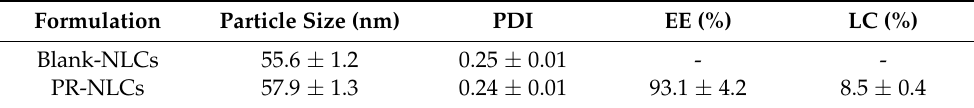
Table 1. The particle size, PDI, EE, and LC of blank-NLCs and PR-NLCs ( n = 3, mean ± SD). Formulation Particle Size (nm)